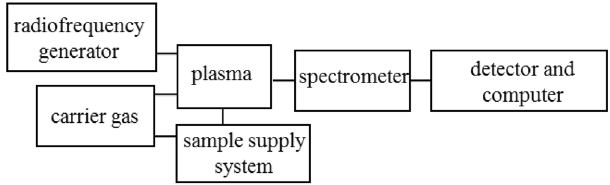
Figure 3. Block diagram of a typical instrument used for